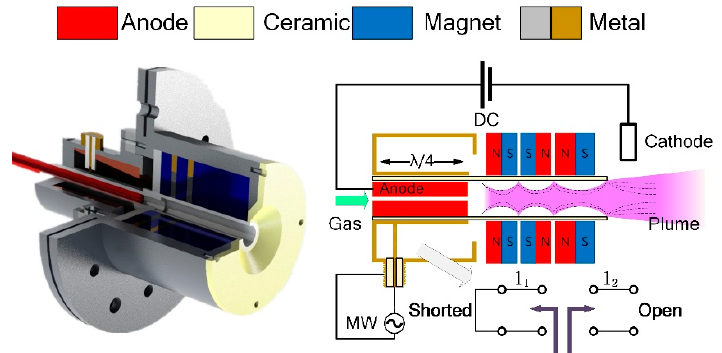
Figure 22. Schematic cutaway view of the MW coaxial resonant cusped field thruster and its operational schematic diagram.